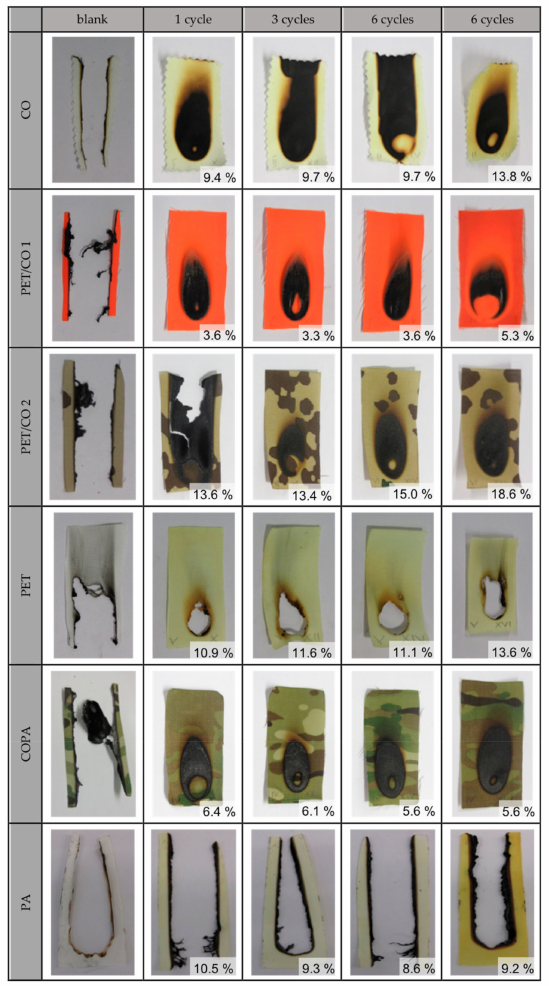
Figure 8. Photographs represent the flame test of the blank fabrics and the fabrics with two di ff erent add-ons of flame retardant after di ff erent washing cycles. The add-ons after the washing test in the